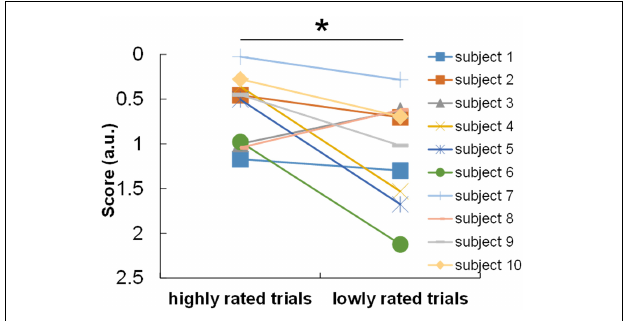
FIGURE 3 | Comparison of task scores between highly and lowly rated trials in terms of subjective confidence in answers. * p < 0.05.